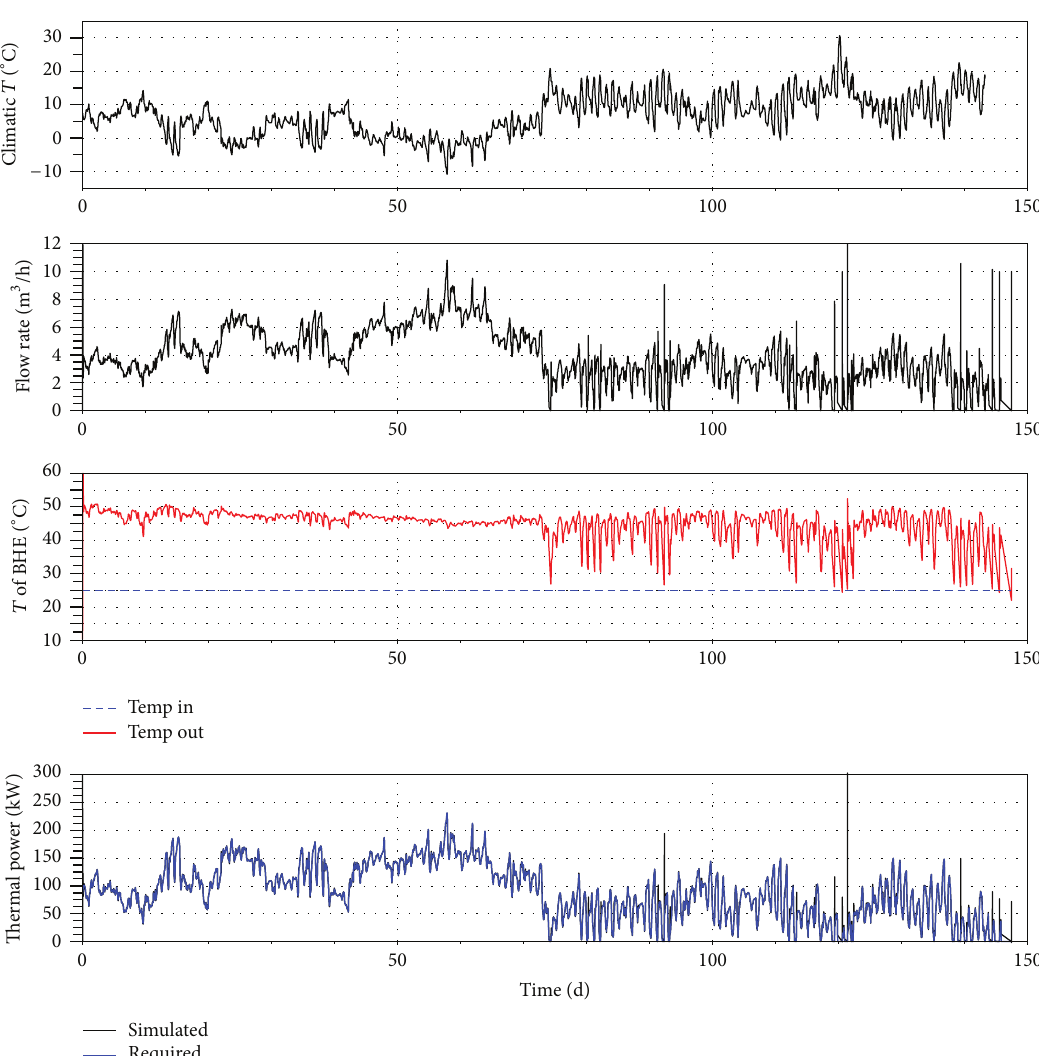
Figure 14: With real data of climatic temperature of the first half of 2005, the associated need for heating and chilling is calculated for the SuperC building (required thermal power) using the mean 𝑈 -value of 7.9285 kW/K [12]. Assuming the heaters in the building returning the water constant to 25 ∘ C, this will be the inlet temperature of the BHE. The outlet temperature and flow rate of the circulation water from the BHE are simulated. Their associated thermal power in the first half year is compared with the calculated required thermal power of the